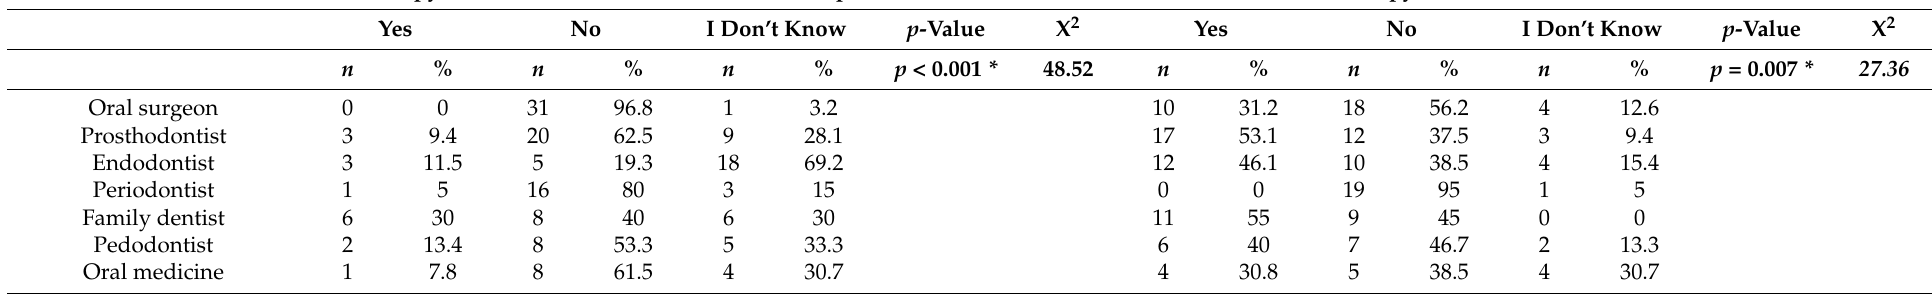
Table 3. Comparison of answers of different non-orthodontic